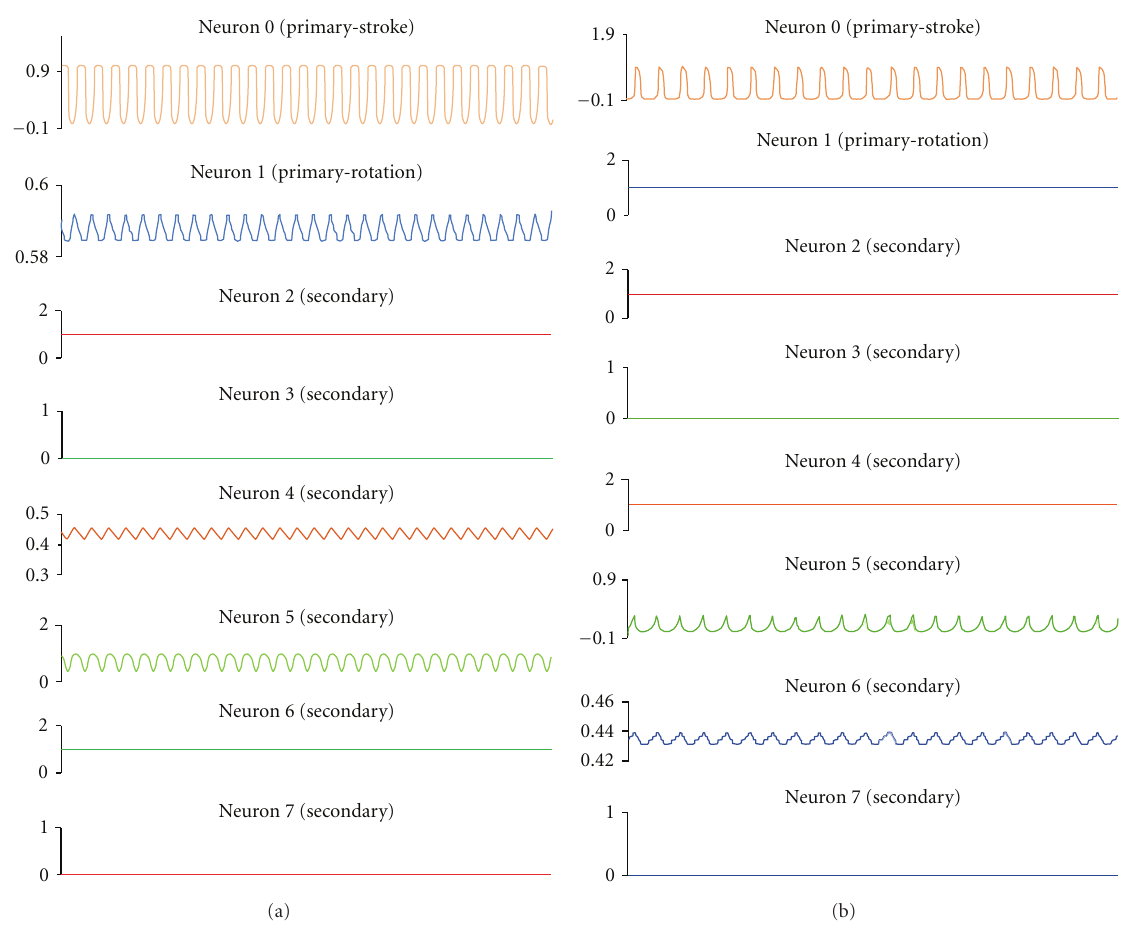
Figure 32: (a) shows the neuron output state dynamics of each neuron in the polymorphic controller when presented with a cruise command, whose the external sensor signal is “0.” It can be seen that the neurons 0, 1, 4, and 5 form a composite module with same frequency and would not comply with established criteria for frequency-based grouping. But, the cruise mode controller has been verified to form a single frequency composite stroke and rotation control module as shown in Figure 21(a) and generating appropriate cruise behavior in the MFWR. (b) shows the neuron output state dynamics of each neuron in the polymorphic controller when presented with an altitude gain command whose external sensor signal is “1.” It can be seen that the neurons 0, 5, and 6 forms same frequency group for stroke control and a constant rotation produced by saturated neuron 1. The altitude gain mode controller form a two separate independent stroke and rotation control blocks template as shown in Figure 21(b) and generates appropriate altitude gain behavior in the